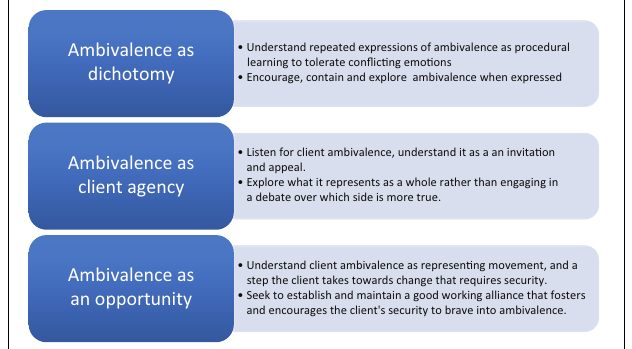
FIGURE 2 | Main discussion points and clinical